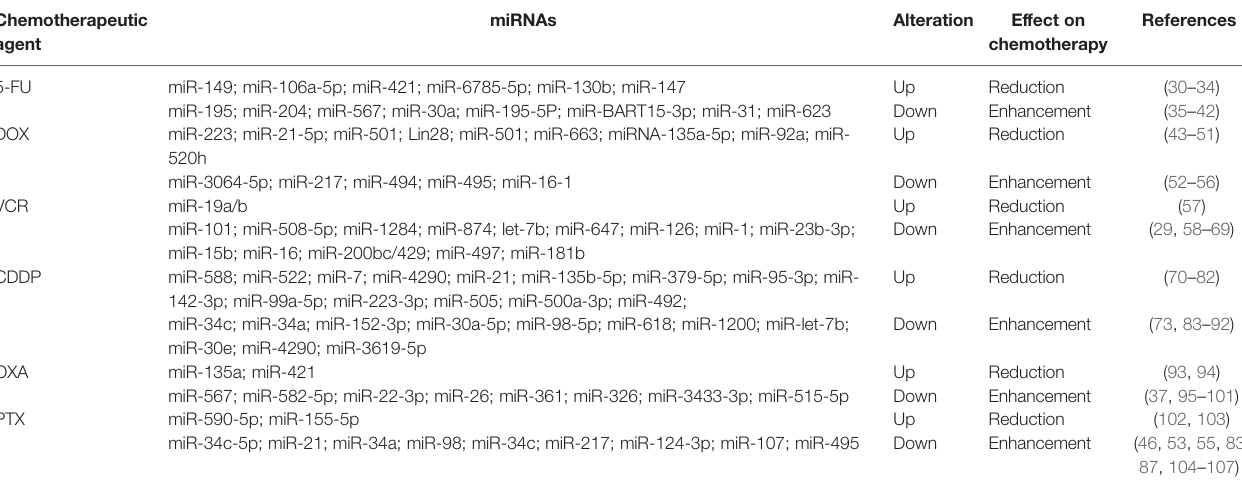
TABLE 1 | MiRNA and drug resistance in